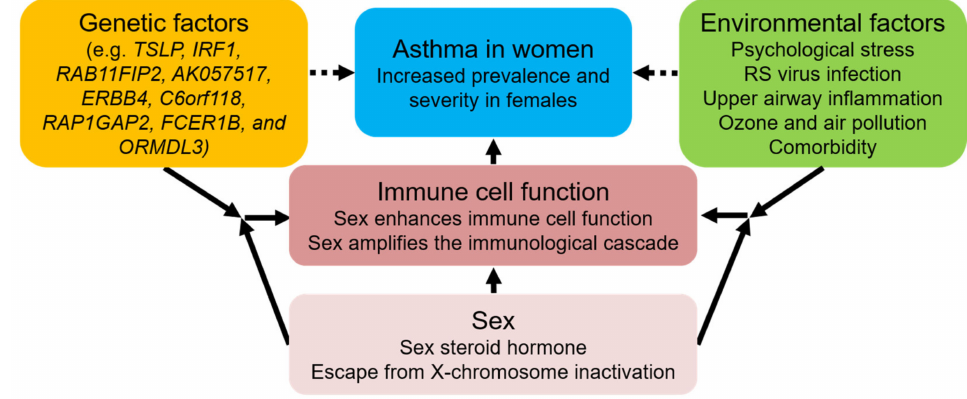
Figure 2. Schematic diagram illustrating the role of sex in the exacerbation of allergic asthma. Sex is associated with worse clinical outcomes of allergic asthma, including relatively higher prevalence, hospitalization rate, and relapse rate. This association is partly mediated by sex hormone-related alteration of innate and adaptive immune cells. Furthermore, in the immunological cascade from sensing allergens to airway cells, including epithelial cells and dendritic cells, to effector cell ac- cumulation in surrounding airways, their responses are amplified based on sex. Meanwhile, the association of sex with other environmental factors such as psychological stress, respiratory infection, and upper airway inflammation induces sex-related dysmorphism of immune responses in asthma. In addition, the interplay between sex and genetic factors such as TSLP SNP rs2289276 or rs1837253 may also contribute to female-specific asthmatic immune responses. Thus, sex plays a multifaced role in female-dominant asthma pathogenesis. TSLP, thymic stromal lymphopoietin; SNP, single nucleotide polymorphism; RS, respiratory syncytial